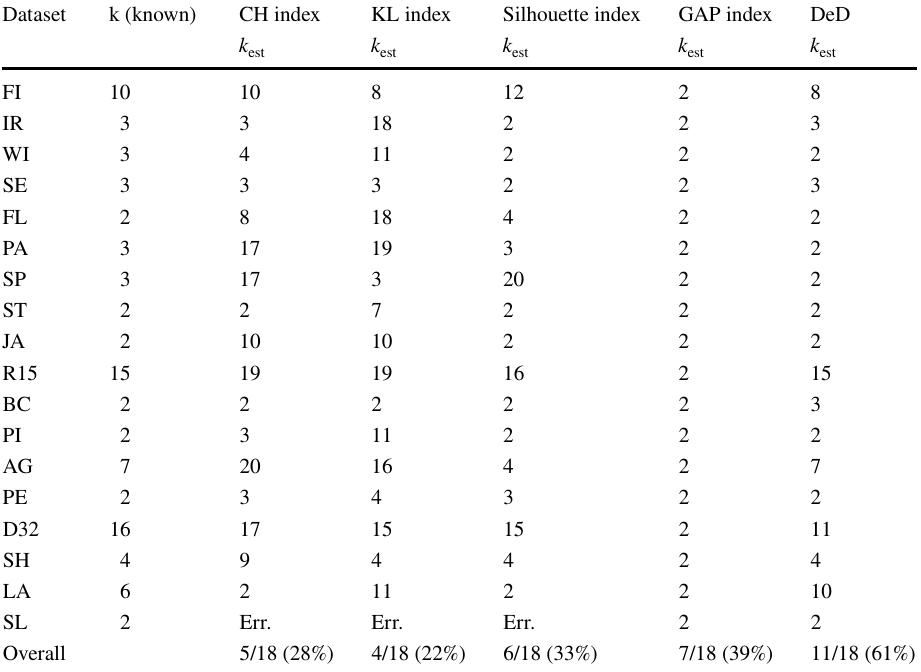
Table 5 Optimal clustering numbers for the 18 real datasets